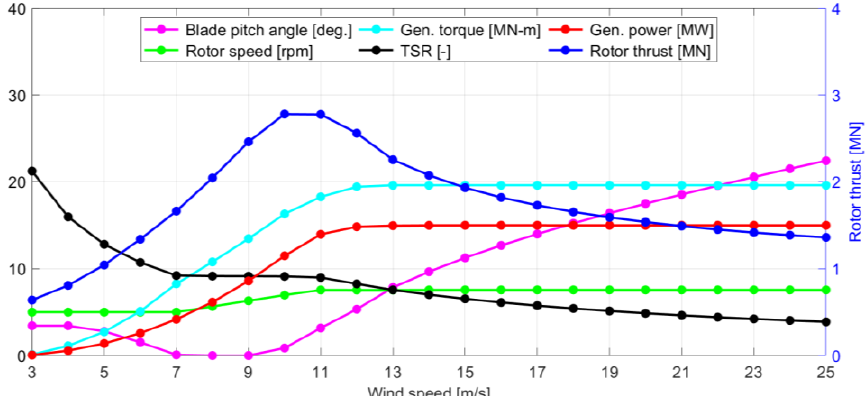
Figure 4. Steady-state analysis results of the 15 MW floating offshore wind turbine.